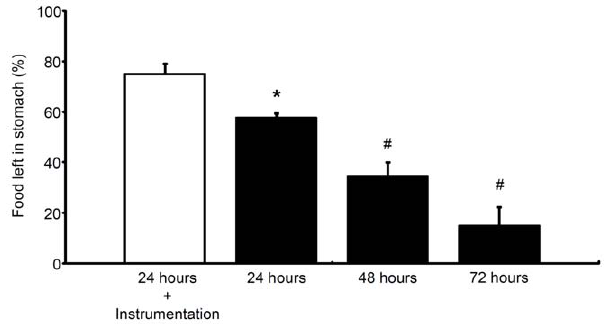
Figure 3. Gastric evacuation time. Values were taken at 24, 48 and 72 hours following forced feeding of P. borchgrevinki with fish white muscle amounting to , 2% of body mass. The open bar represents the instrumented fish used in cardiorespiratory in vivo experiments (N=9) and closed bars represent non-instrumented fish (N=6–7). Values are means ( + S.E.M.). * denotes significantly different value (p , 0.05) between instrumented and uninstrumented fish at 24 hours postpran- dial and # denotes significantly different value (p , 0.05) from the preceding sampling time in uninstrumented fish.